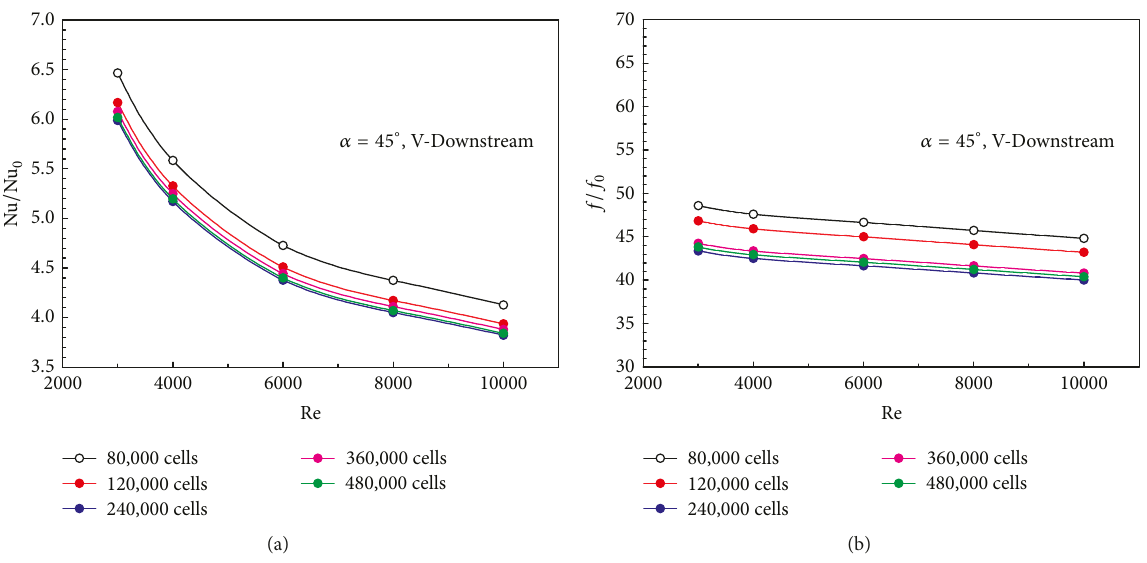
Figure 2: Grid independence for (a) Nusselt number and (b) friction factor of 45 ∘ V-wavy plate for V-Downstream.